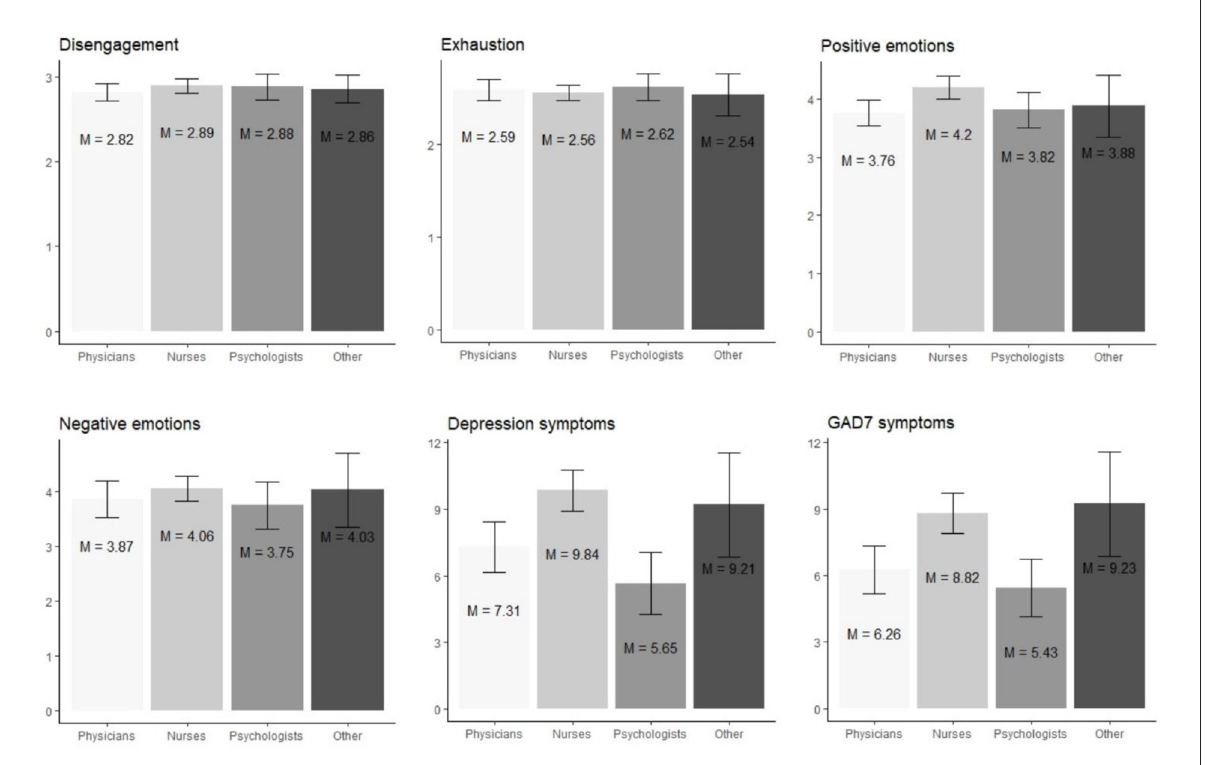
FIGURE1 Visual comparison of levels of Exhaustion, Disengagement, and other variables in the groups of nurses, physicians, psychologists, and other health professions. Mean values are represented by bars and standard deviations are visualized using error